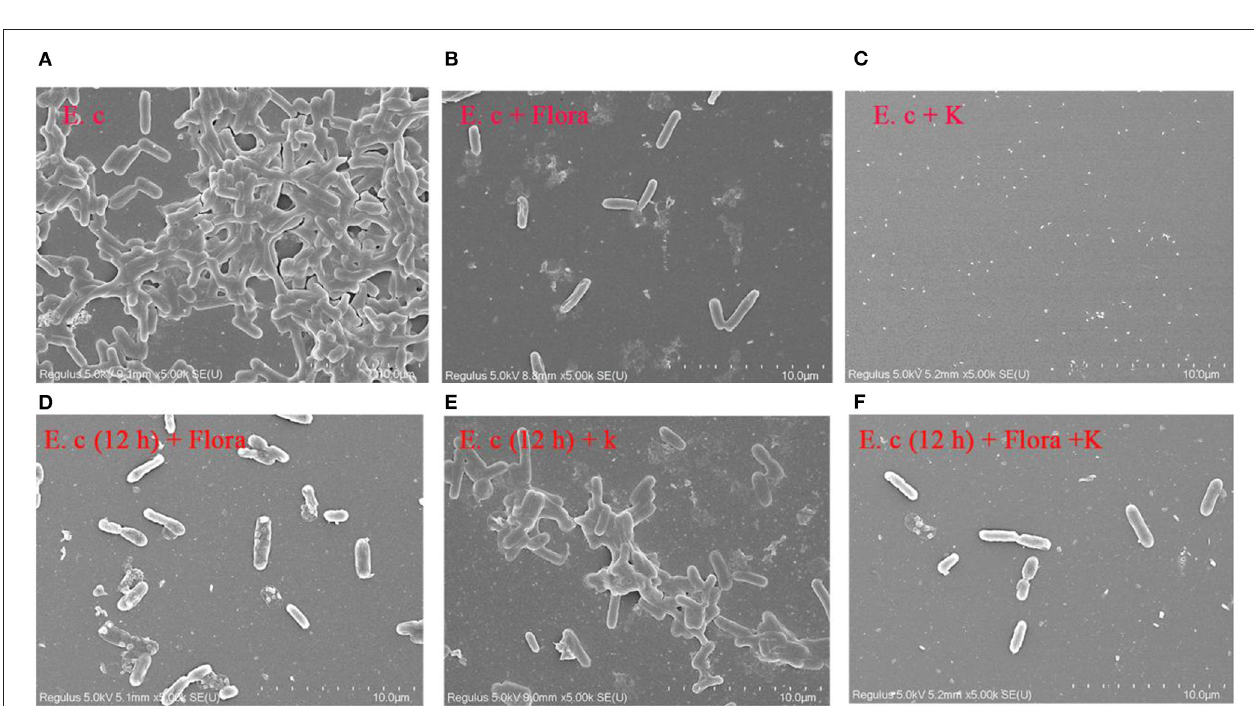
FIGURE 7 | Predicted tertiary structure of the E. coli phage eighth tail fiber protein. Compared with the KM18 eighth tail fiber, Flora has special β strands in the eighth tail fiber.